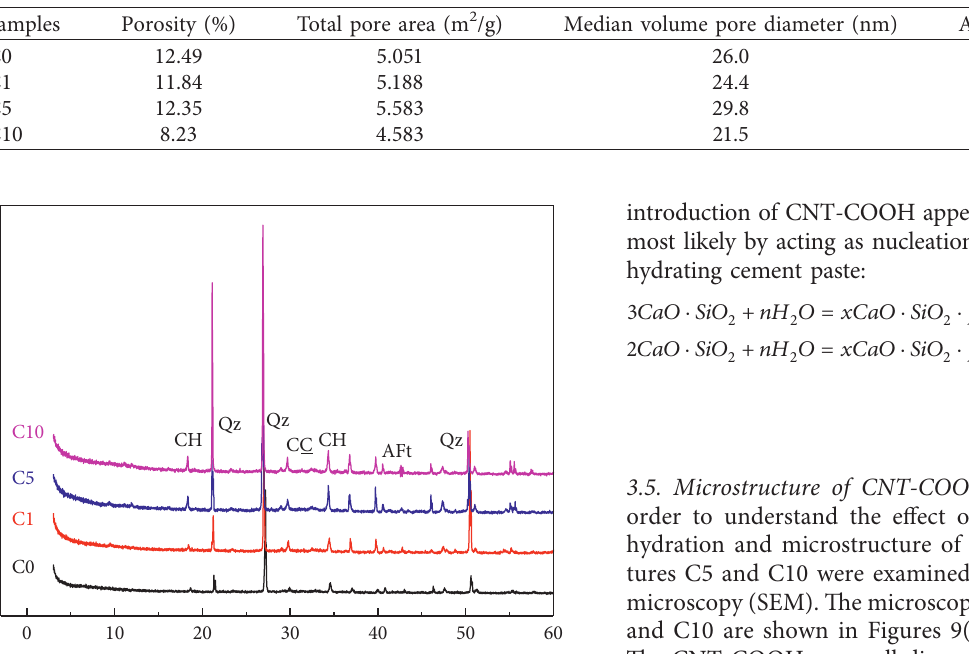
Figure 7: The log differential intrusion with pore diameter of CNT-mortar samples with the various dosage of CNT-COOH after 28 days of curing time. Table 5: MIP analysis of CNT-mortar at 28 day.